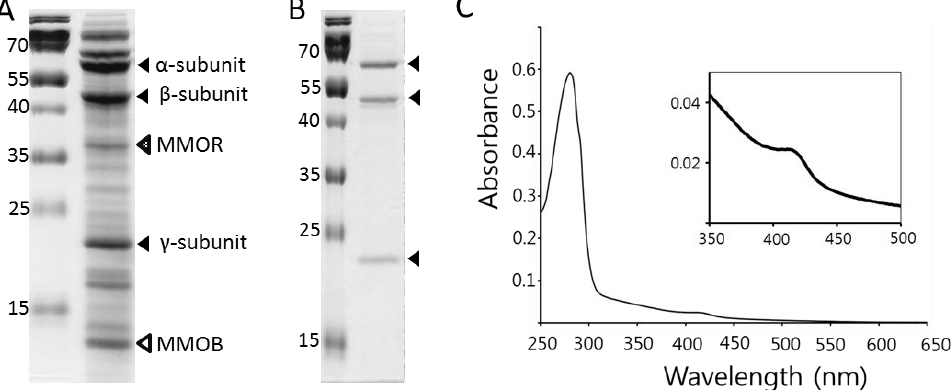
Figure 3. Expressed sMMO enzymes from M. sporium 5 and purified hydroxylase, regulatory, and reductase components. ( A ) Left lane represents the protein size-marker (unit: kDa), and right lane represents the cell lysates from M. sporium 5. MMOH including α - (59.9 kDa), β - (45.2 kDa), and γ - (19.3 kDa) subunits (black arrowheads) showed high expression in cell lysates. Two essential components, including reductase (MMOR; 37.4 kDa; a dotted arrowhead) and regulatory (MMOB; 14.9 kDa; an empty arrowhead) components, were also detected after expression. ( B ) Purified MMOH subunits after a three-step purification process are represented as arrows, and these highly purified enzymes were further applied to measure enzyme activities. ( C ) UV–visible absorption spectrum of purified MMOH from M. sporium 5 in 25 mM sodium phosphate buffer at pH 7.0. Inset shows the enlarged spectrum from 350 to 500 nm.